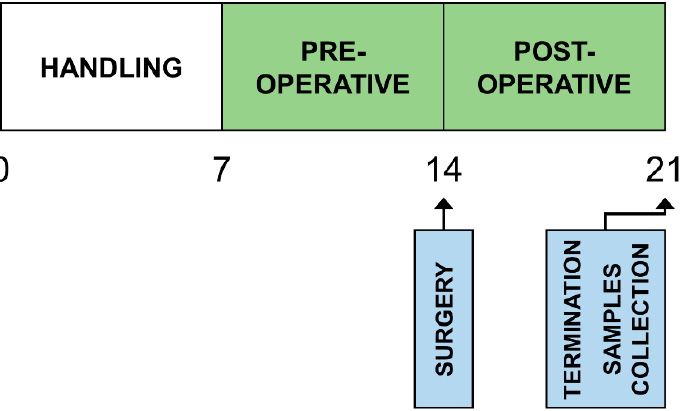
Figure 1. Scheme of the experimental protocol. The boxes represent the phases of the experiment; numbers represent the experimental days. The administration of the lipid emulsions is marked green.